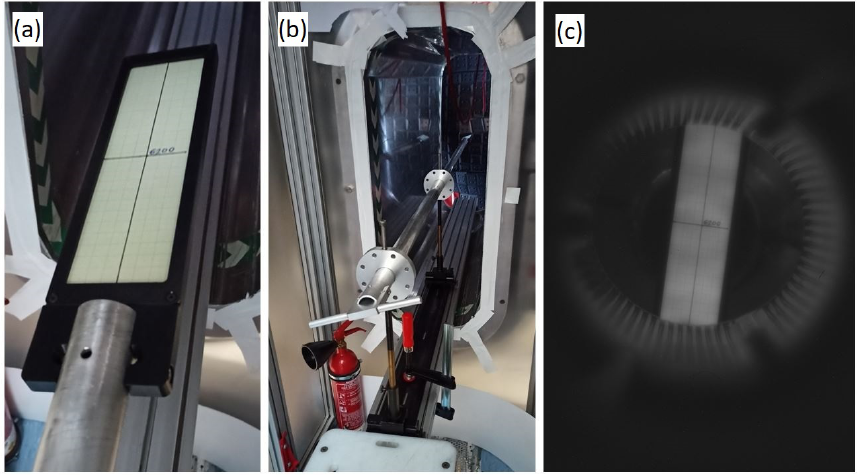
Figure 8. Photo of the semi-transparent screen ( a ); calibration rod setup ( b ); CMOS camera image of the semi-transparent screen ( c